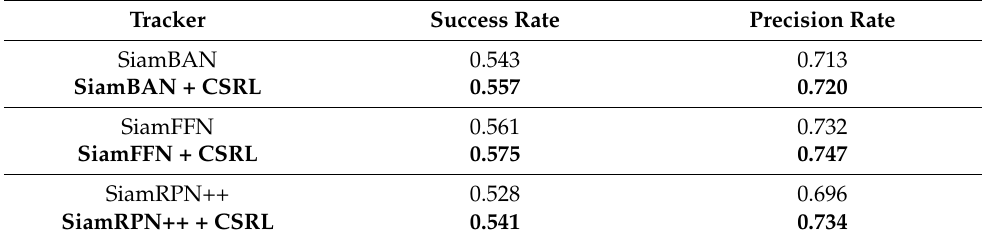
Table 4. Ablation study of CSRL. Tracker Success Rate Precision Rate